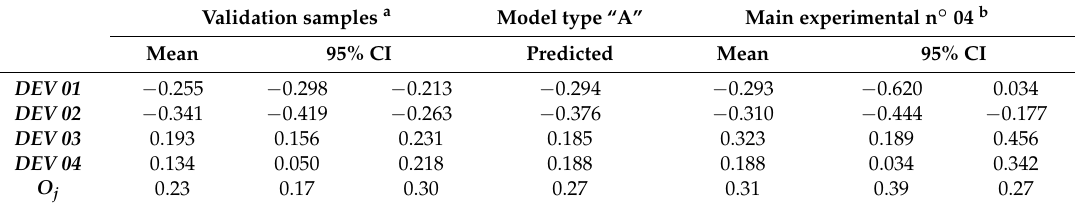
Table 8. Comparative results of the multi-criteria optimization model type